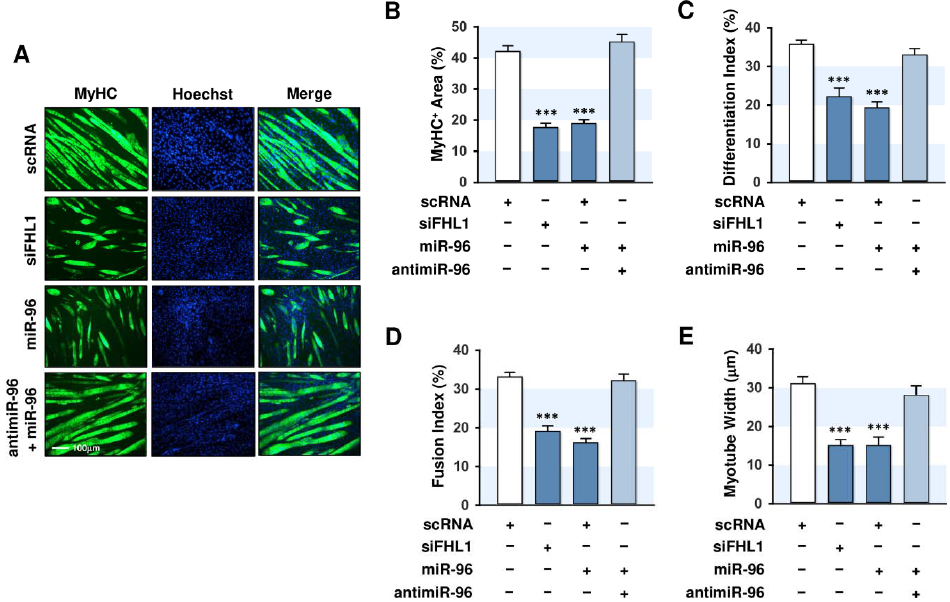
Figure 6. MiR-96-5p impairs myogenic di ff erentiation. C2C12 myoblasts were transfected with 100 nM of scRNA control, siFHL1, miR-96-5p mimic, or antimiR-96-5p. ( A ) Immunofluorescence staining